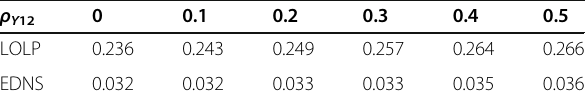
Table 2 Impact of WPFE correlation on reliability